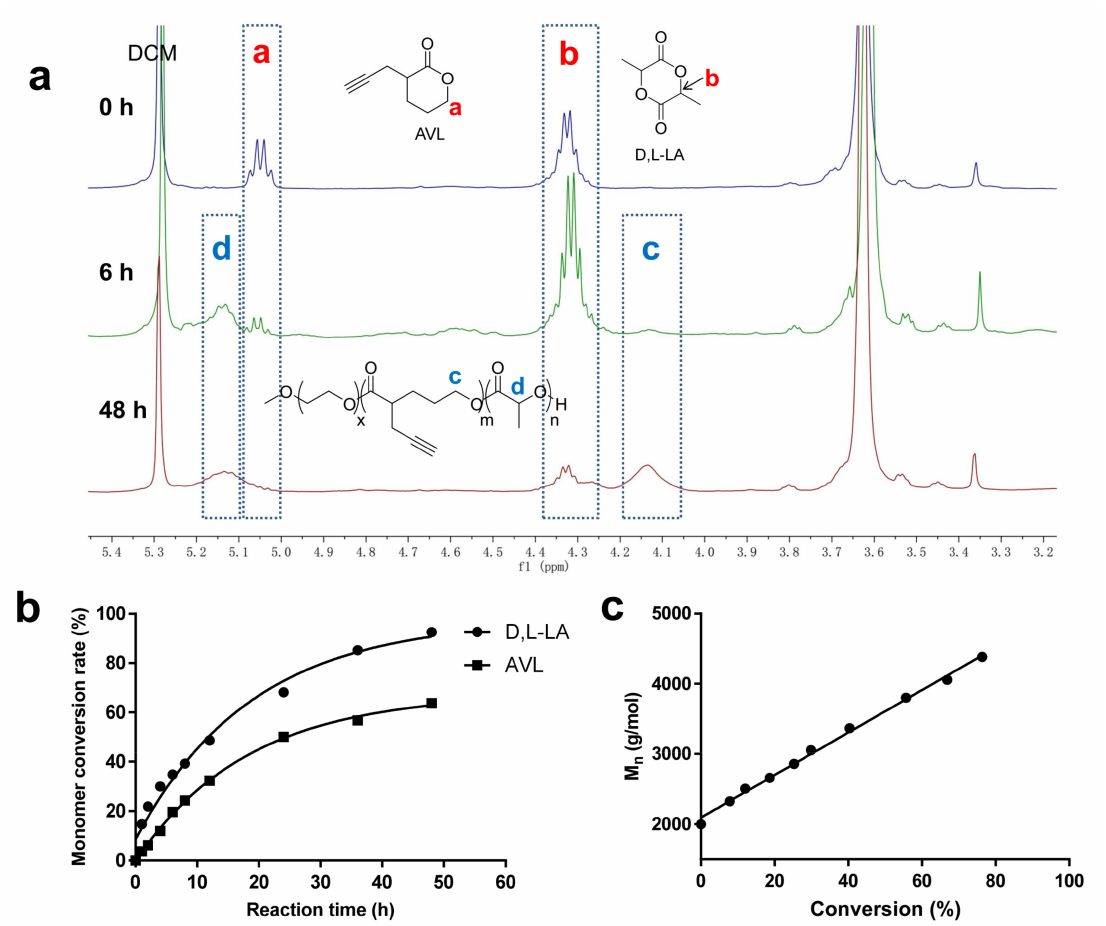
Figure 2. The 1 H NMR of different reaction time of polymerization of D,L-LA and AVL monomer initiated by mPEG 2K ( a ). Plot of monomer conversion in the ring-opening polymerization ( b ). Plot of number-average molecular weight ( M n ) of copolymer against total conversion of two monomers (%) in the ring-opening polymerization ( c ). Conditions: [mPEG 2K ] = 0.25 mM, [mPEG 2K ]:[D, L-LA]:[AVL] =